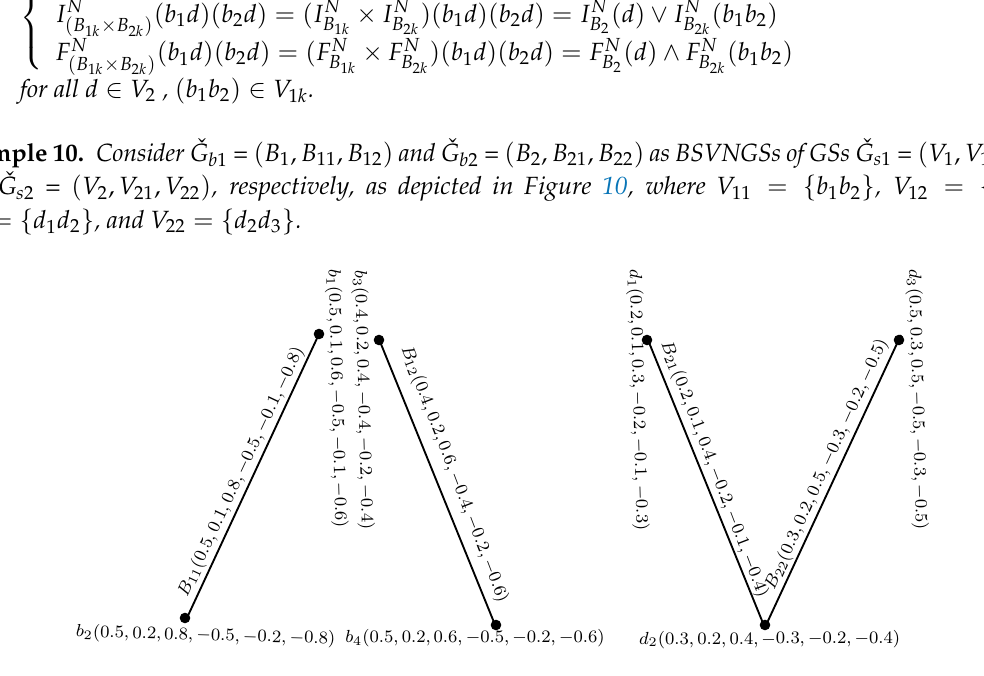
Figure 10. Two BSVNGSs ˇ G b 1 and ˇ G b 2 Figure 2.10: Two BSVNGSs ˇ G b